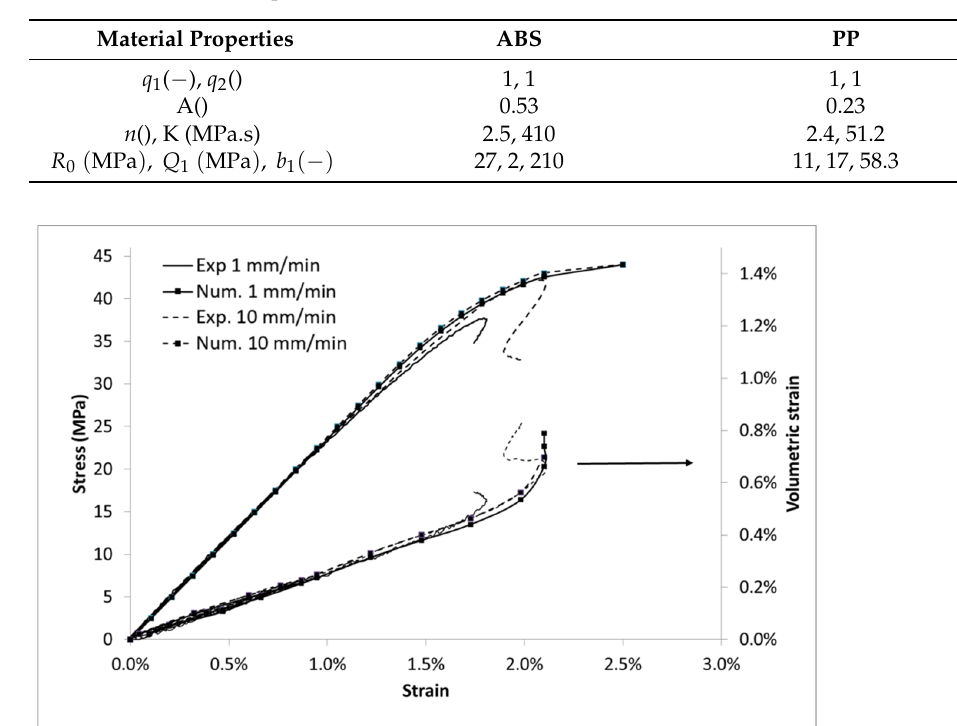
Table 3. Material model parameters for ABS and PP.